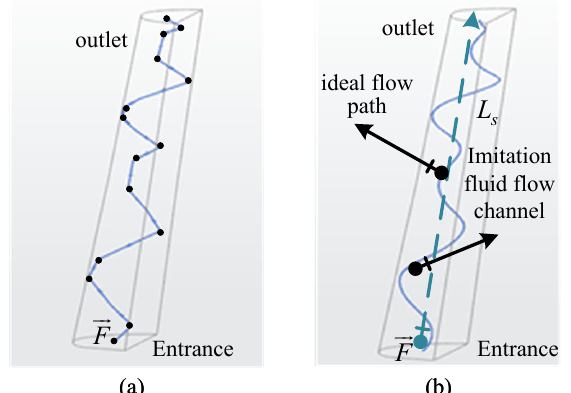
Figure 5. Schematic diagram of the initial reference pipe-network topology skeleton line for a single channel: ( a ) Flow collision simulation and control vertices, and ( b ) cubic spline fitting of the fluid flow path.